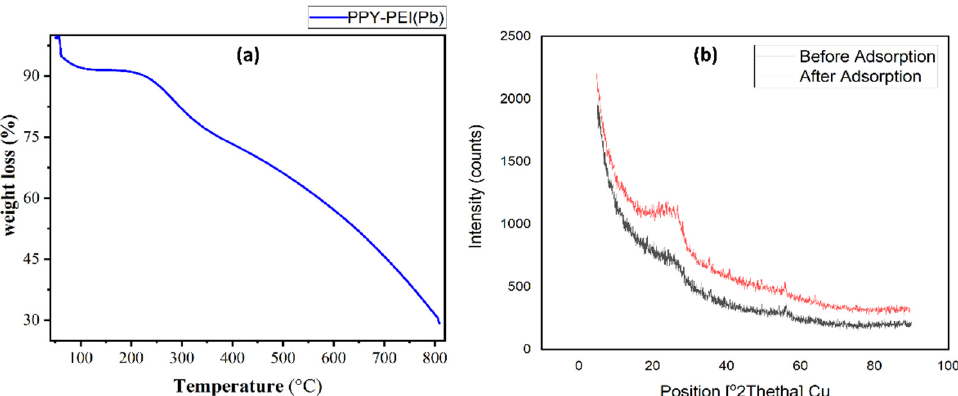
Figure 5. ( a ) TGA graph showing the thermal degradation of Ppy ‐ PEI, and ( b ) XRD graphs showing polypyrrole ‐ polyethyleneimine before and after the adsorption of lead ion. (After adsorption in red lines and before adsorption in black